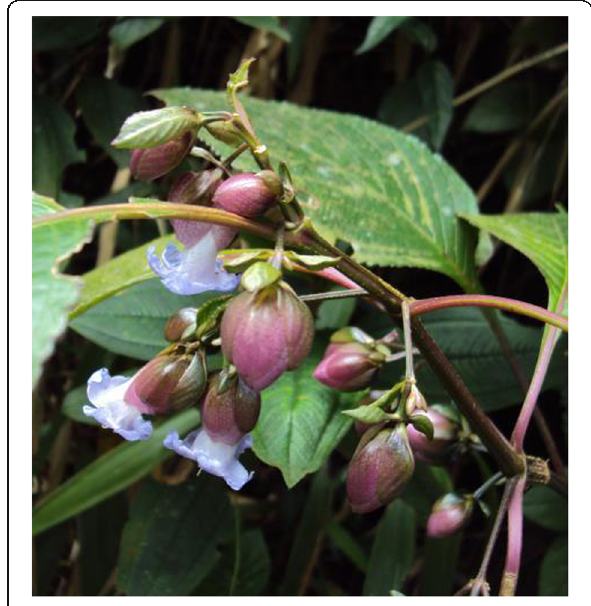
Fig. 1 Habitat of Strobilanthes heyneanus Nees. Taxonomic classification: kingdom, plant kingdom; division, angiosperms; class, Dicotyledoneae; subclass, Gamopetalae; family, Acanthaceae; genus, Strobilanthes ; species,